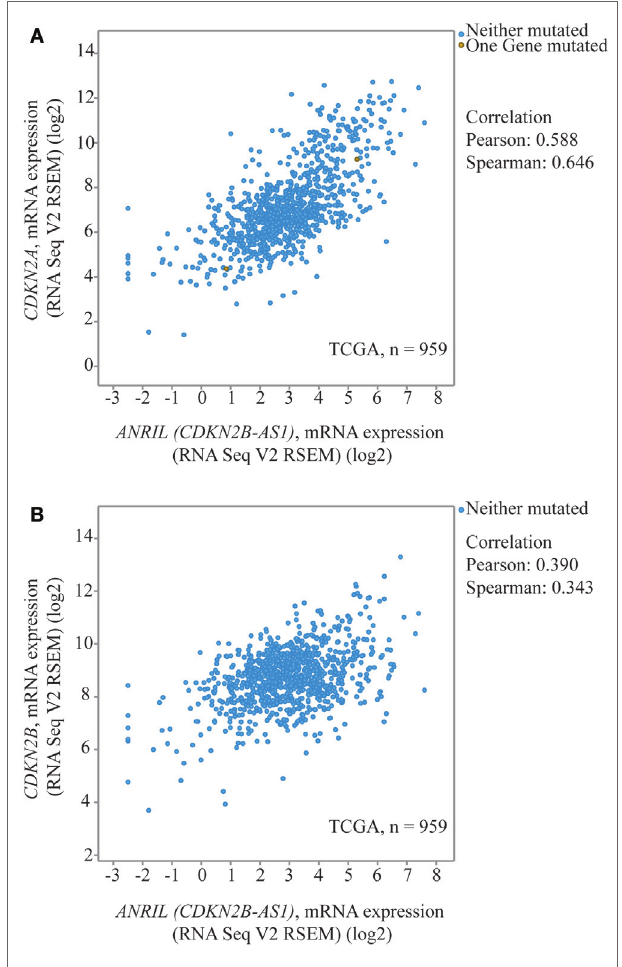
FigUre 4 | Dot-plots from Tcga data for invasive breast cancer to illustrate correlations between 9p21 transcripts. ANRIL ( CDKN2B-AS1 ) and CDKN2A ( p16 INK4a and p14 ARF ) (a) and CDKN2B ( p15 INK4b ) (B) (38,